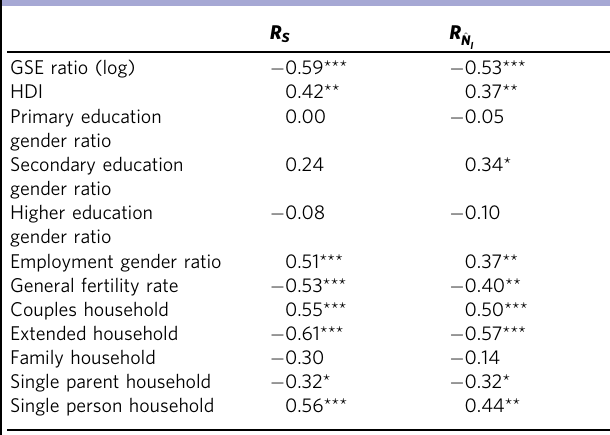
Table 2 Semi-partial correlation values (Pearson) between R R ^ S and N l and the sociodemographic features of 51 municipalities in the